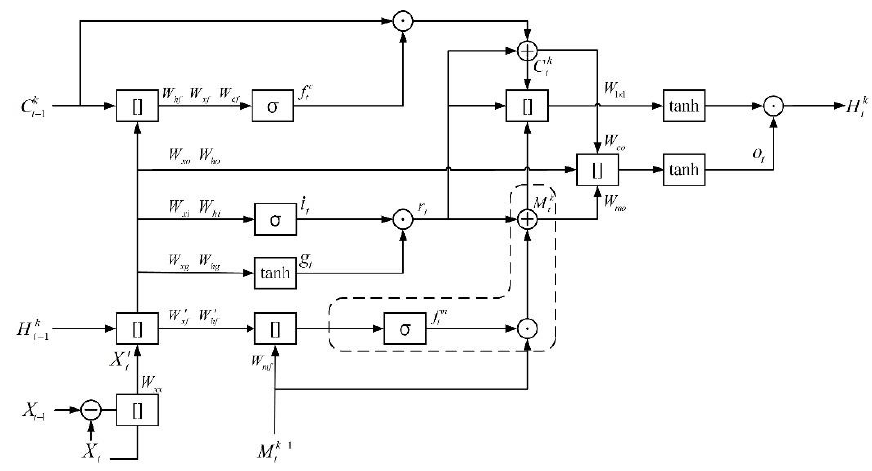
Figure 2. DMLSTM unit.